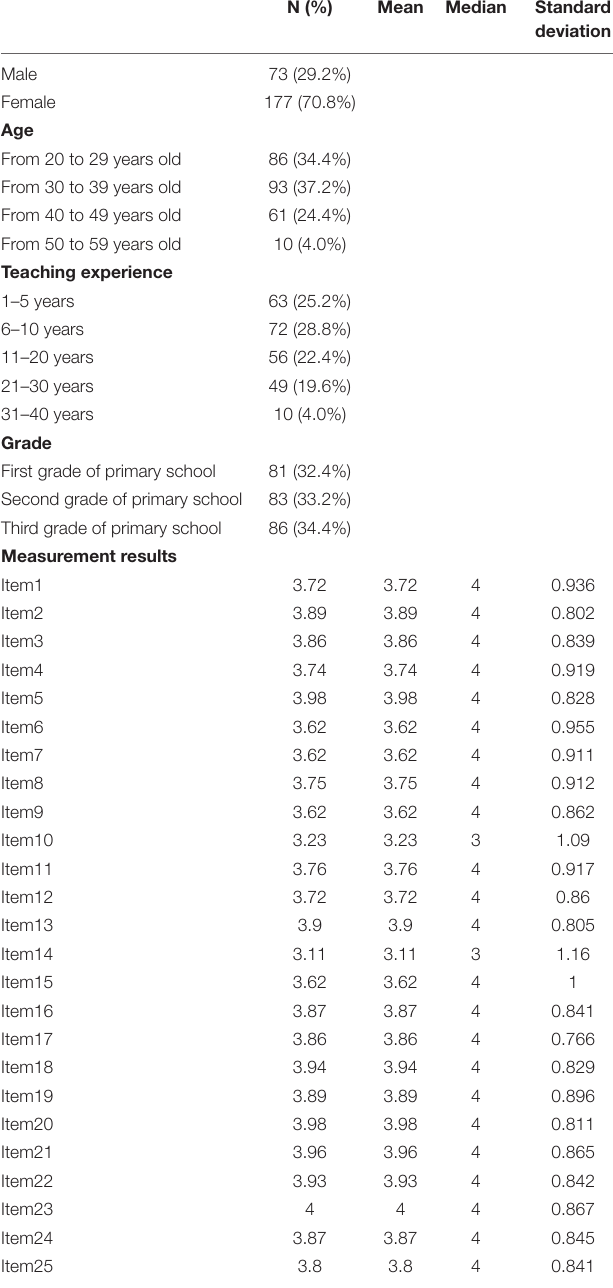
TABLE 1 | Social-demographic information of teachers and the descriptive statistics for the